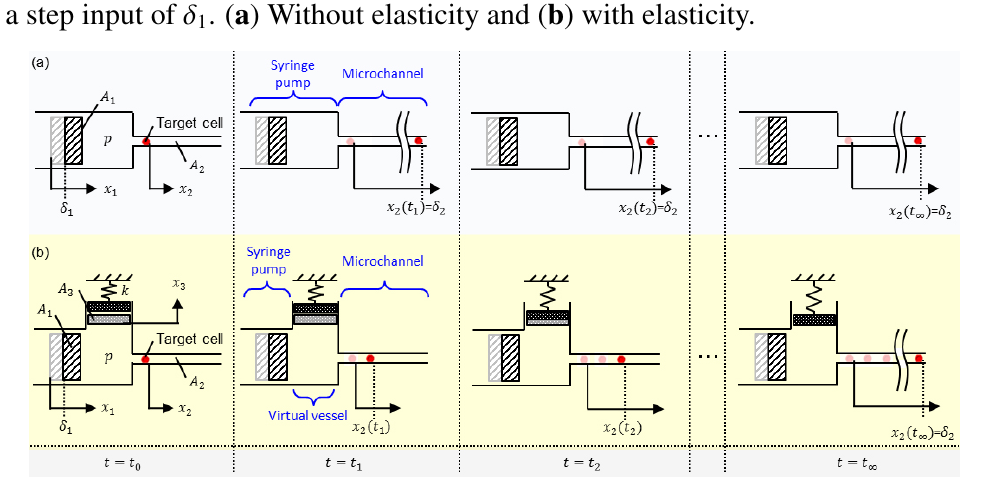
, t , t and t when the syringe pump is actuated ∞ 1 2 3